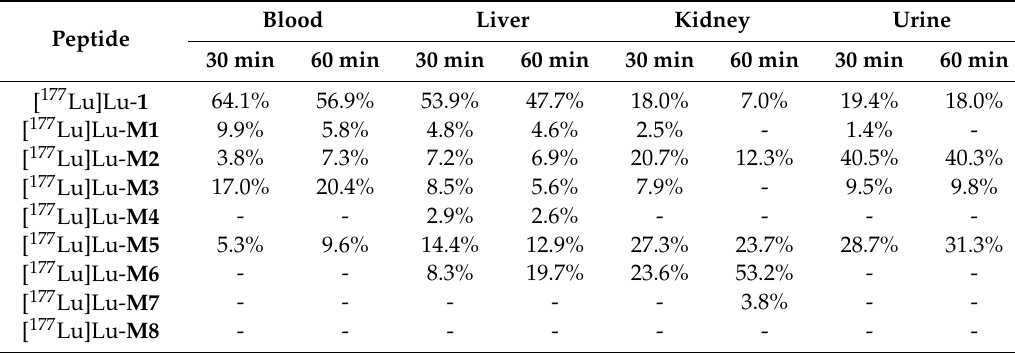
Table 3. Quantification of the percentage of intact radiopeptide and of the radiometabolites as analyzed by radio-HPC of blood and urine, as well as liver and kidneys of BALB / c mice injected with [ 177 Lu]Lu- 1 for di ff erent time points